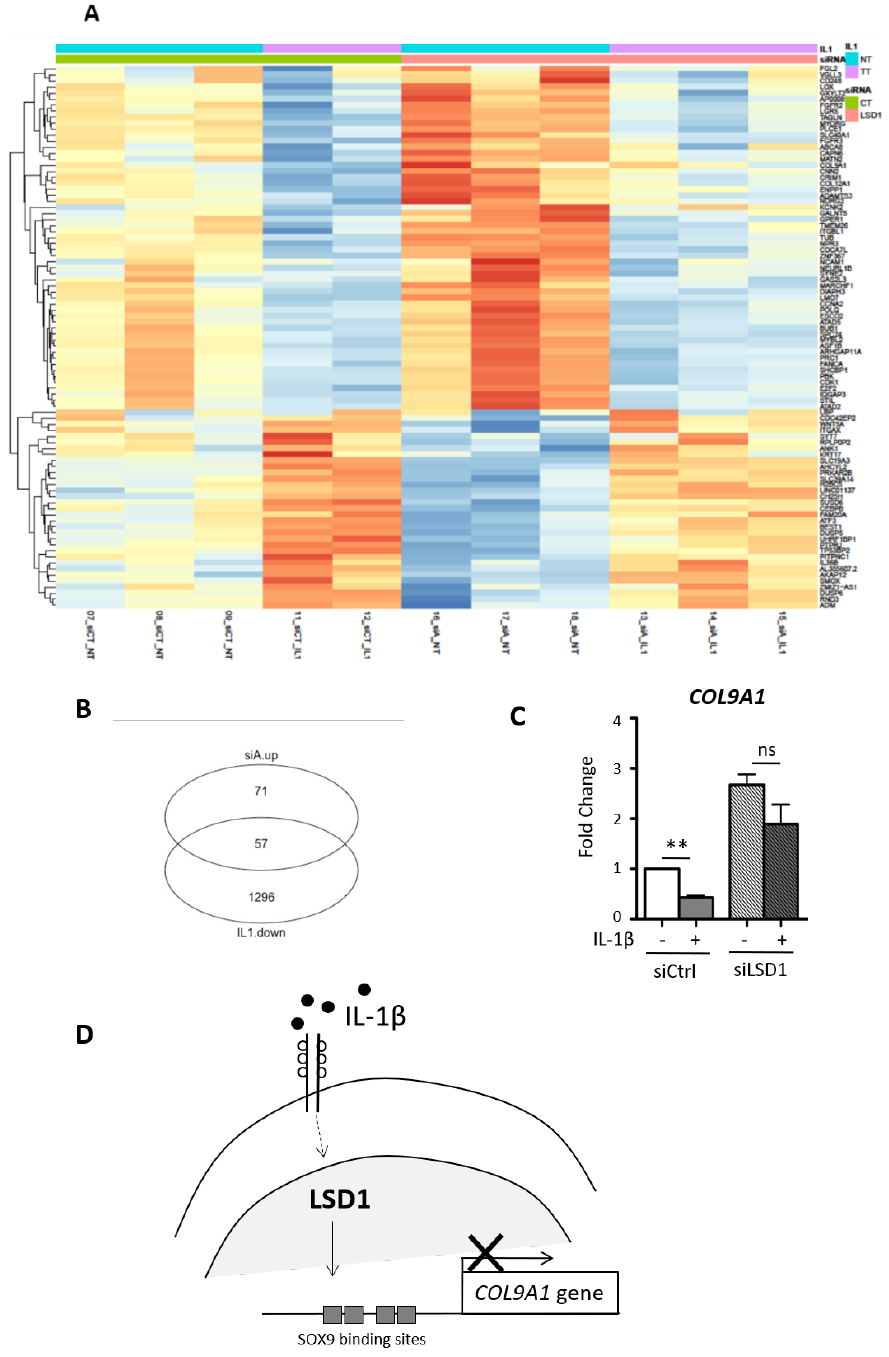
Figure 5. COL9A1 mRNA levels in LSD1-depleted chondrocytes in response to the proinflammatory cytokine IL-1 β . Knock-down of LSD1 was realized following human chondrocyte transfection with siRNA and then treated with IL-1 β for 24 h. ( A ) Heatmap of the genes oppositely regulated by LSD1 and IL-1 β in articular chondrocytes (NT: non-treated, TT: treated with IL-1 β ; CT: transfected with siControl, LSD1: transfected with siRNA against LSD1). ( B ) Diagram indicates 57 genes are simultaneously down-regulated by IL-1 β and up-regulated following LSD1 depletion. ( C ) Real-time PCR was performed from at least 3 independent experiments of additional donors. Results are presented as relative mRNA levels of COL9A1 normalized to RPLP0 (n = 4, Student’s t -test * p < 0.05 ** p < 0.01). ( D ) Schematic representation showing the down-regulation of COL9A1 by IL-1 β is mediated by LSD1.